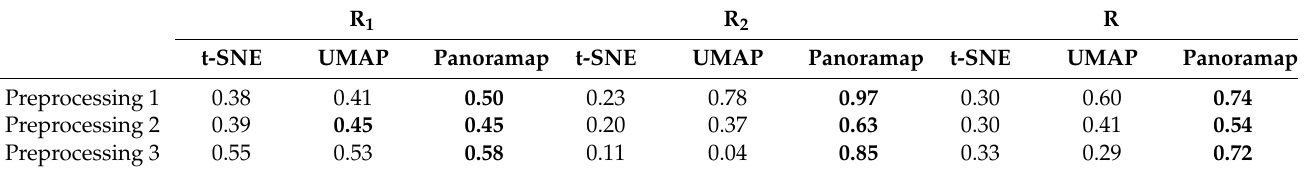
Table 2. Effect of different preprocessing methods on the evaluation metrics for the PBMC3k